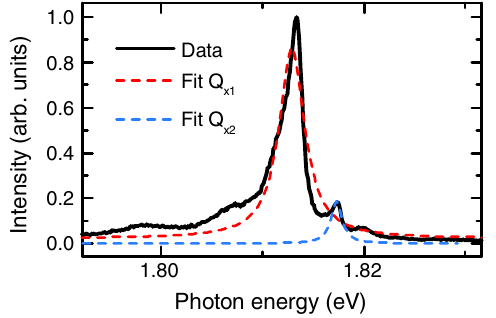
FIG. 8. Typical STML spectrum acquired for a H 2 Pc molecule of type 2, with Lorentzian fits adjusted to the Q